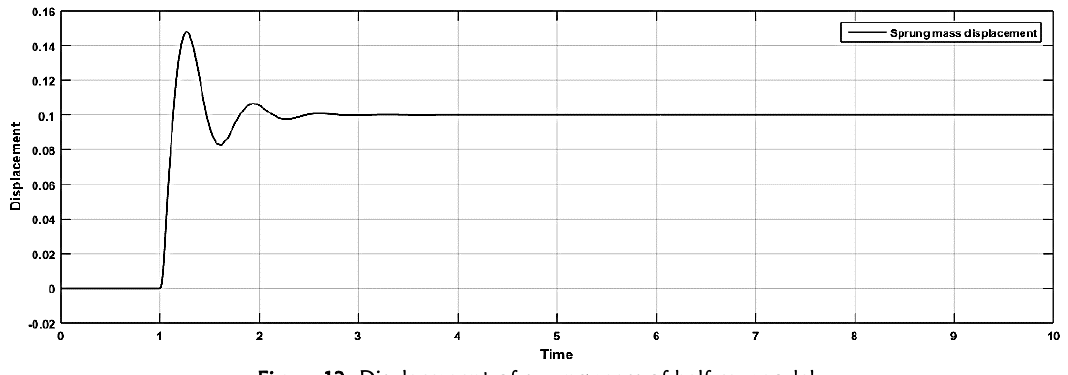
Figure 13. Displacement of sprung mass of half car model